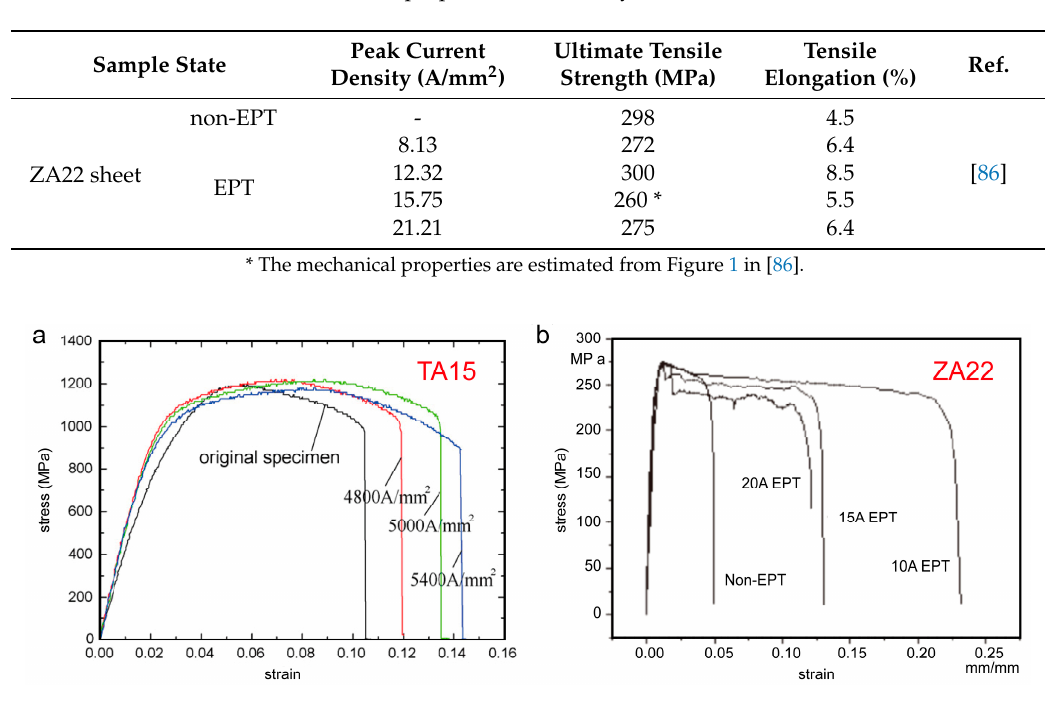
Figure 6. Stress-strain curves of TA15 alloys and ZA22 alloys at different pulse current densities: ( a ) TA15 [62]; and ( b ) ZA22 [86].